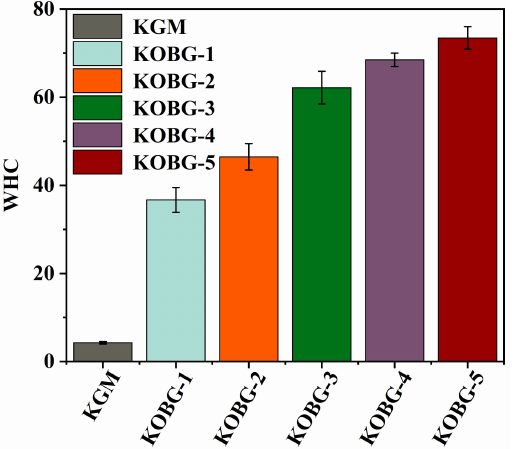
Figure 8. Water-holding capacity (WHC) of composite hydrogel.